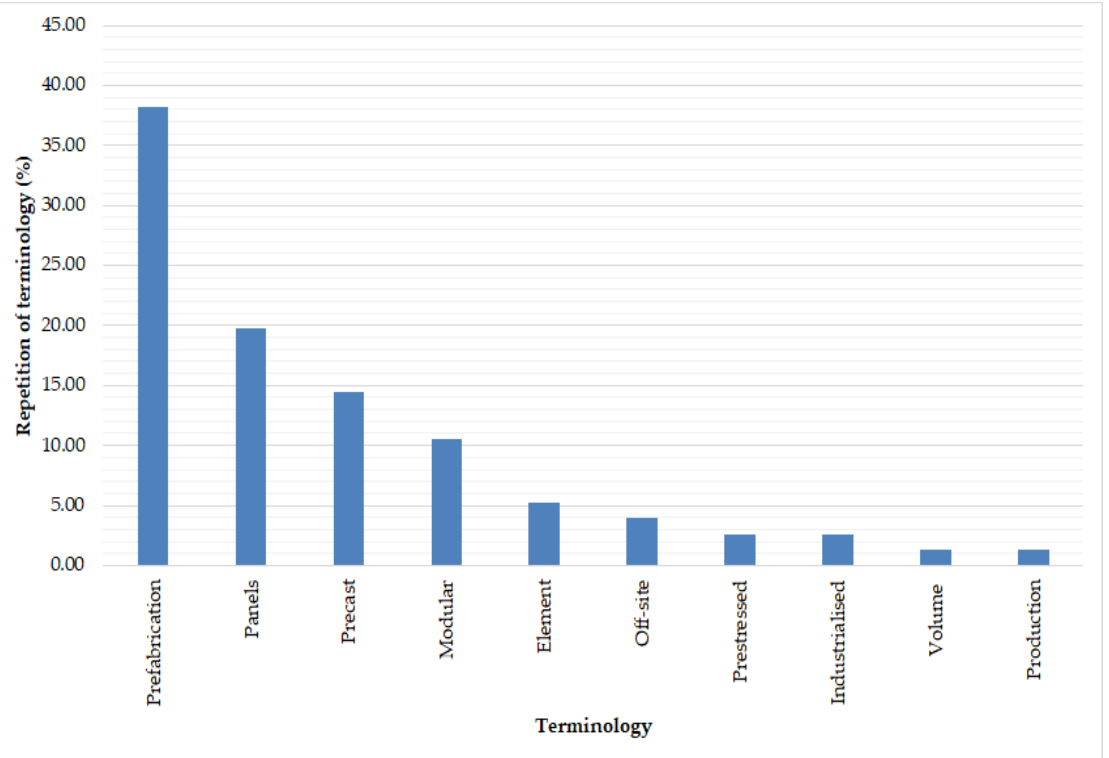
Figure 2. Percentage repetitions of the terminology used in the review articles .